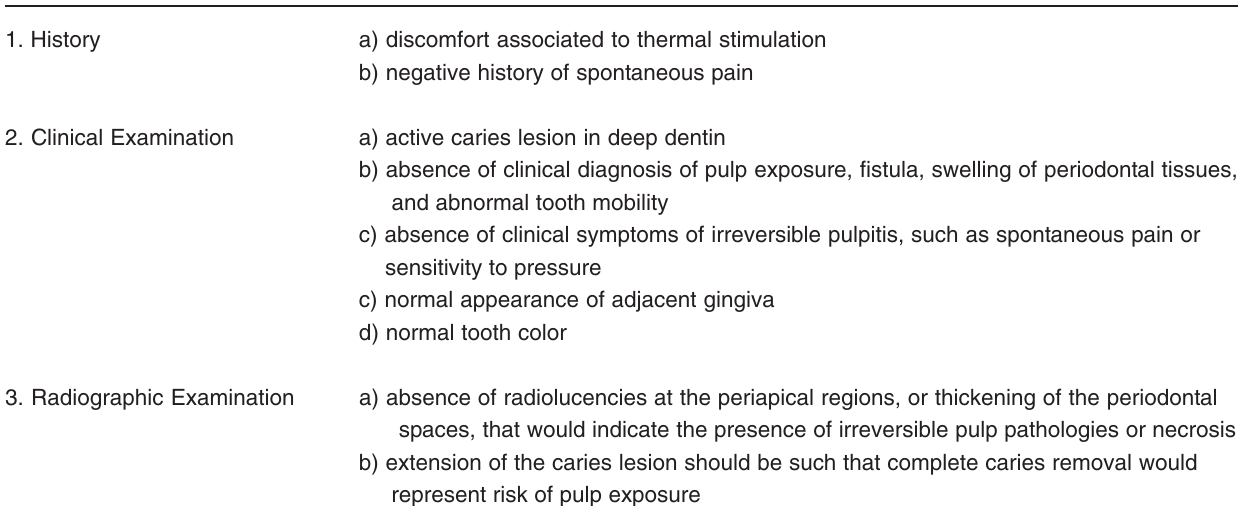
TABLE 1- Indication to undertake the IPT procedure is based on the following findings